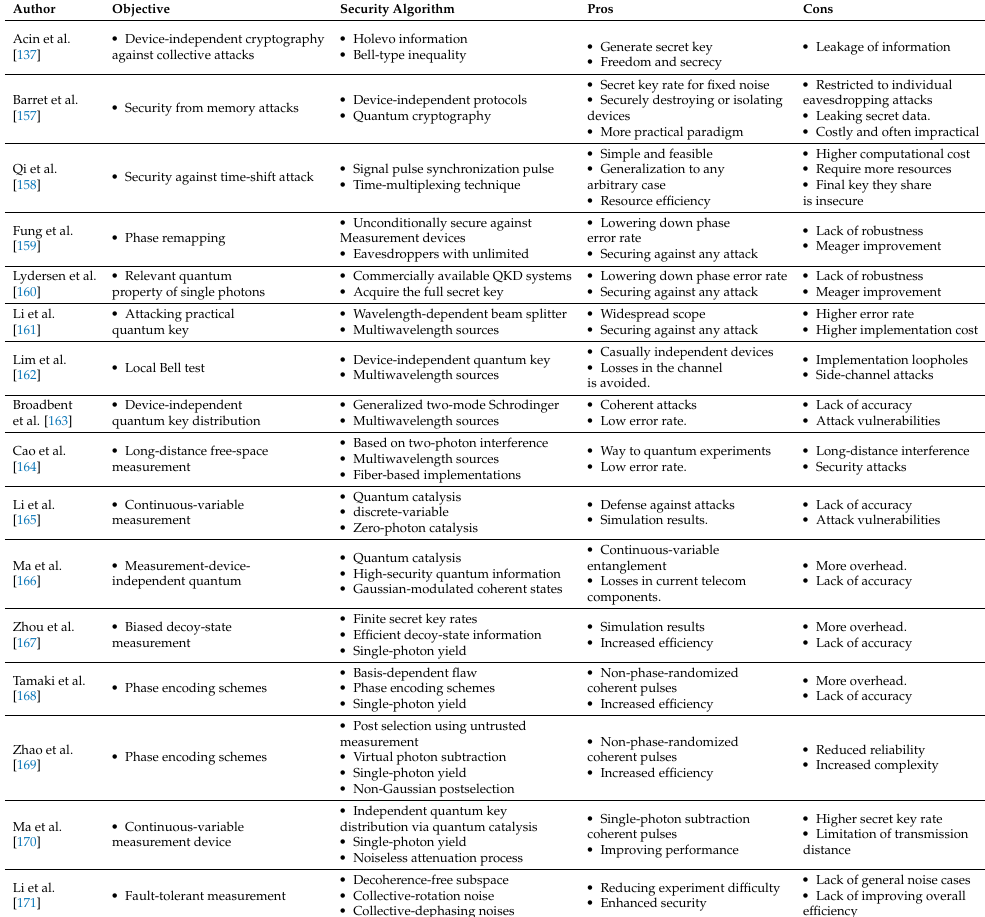
Table 8. Summary of countermeasures and security protocols using measurement-device-independent quantum key distribution